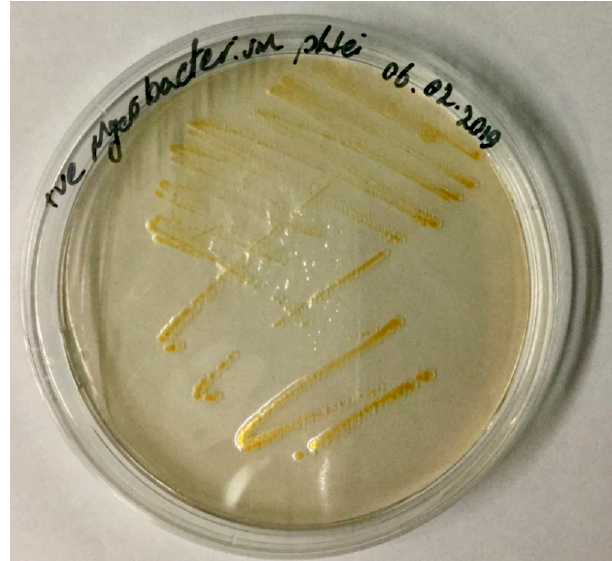
Figure 3. Appearance of M. phlei colonies cultivated on Middlebrook 7H10 agar (Picture from Clinical Division of Fish Medicine, University of Veterinary Medicine repository).